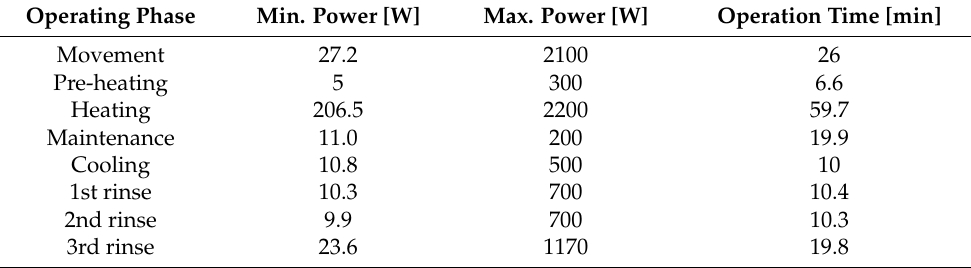
Table 2. Washing-machine power consumption during the operating